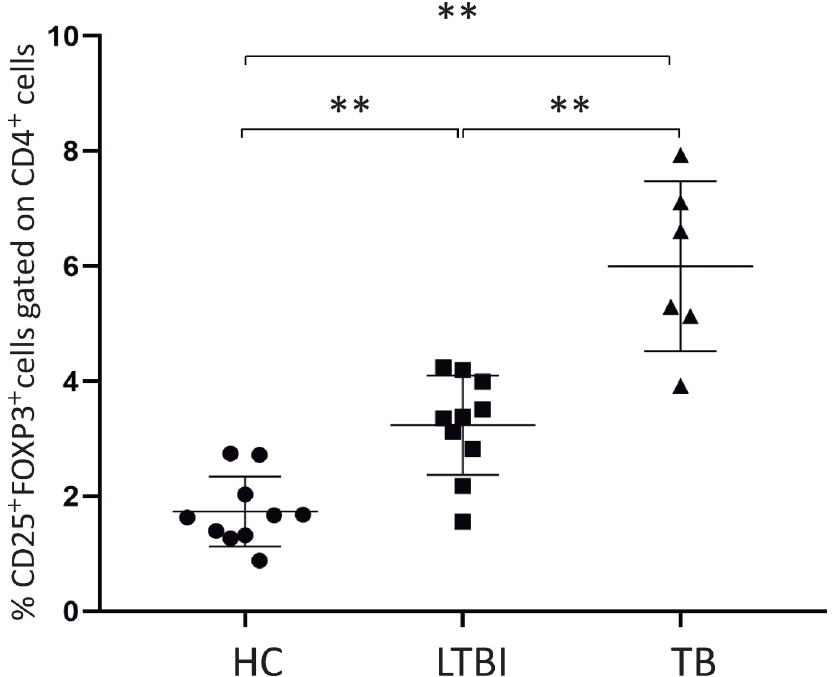
Fig 1. Ex-vivo f requency of CD4 + CD25 high FoxP3 + in TB patients are higher when compared to HC and LTBI subjects. Peripheral blood from healthy control subjects (HC, n = 10), latent infected individuals (LTBI, n = 10), and active pulmonary TB patients (TB, n = 6). Ex vivo samples were collected and immunophenotyped for the presence of CD4 + CD25 high FoxP3 + cells ( �� = p < 0.01).